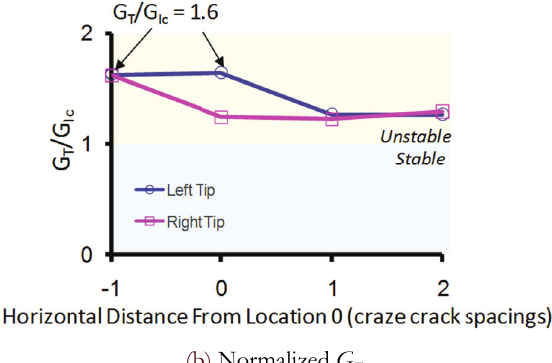
eage B’ is efect n -2, Fig. G T , using (i.e., t the (i.e.,